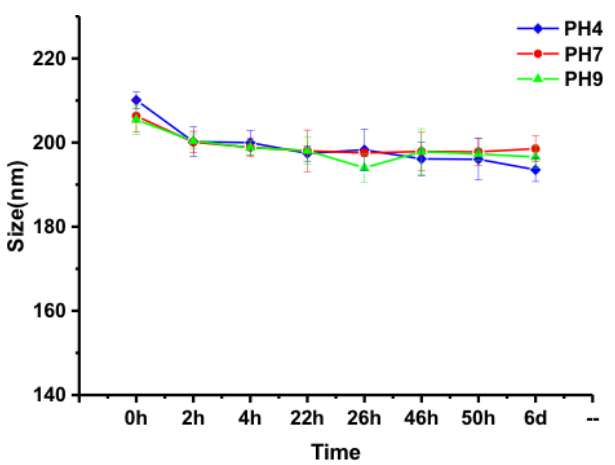
Fig. 5. Colloidal stability study of CS-EGCG nanoparticles at di®erent pH values (4, 7, 9) for six